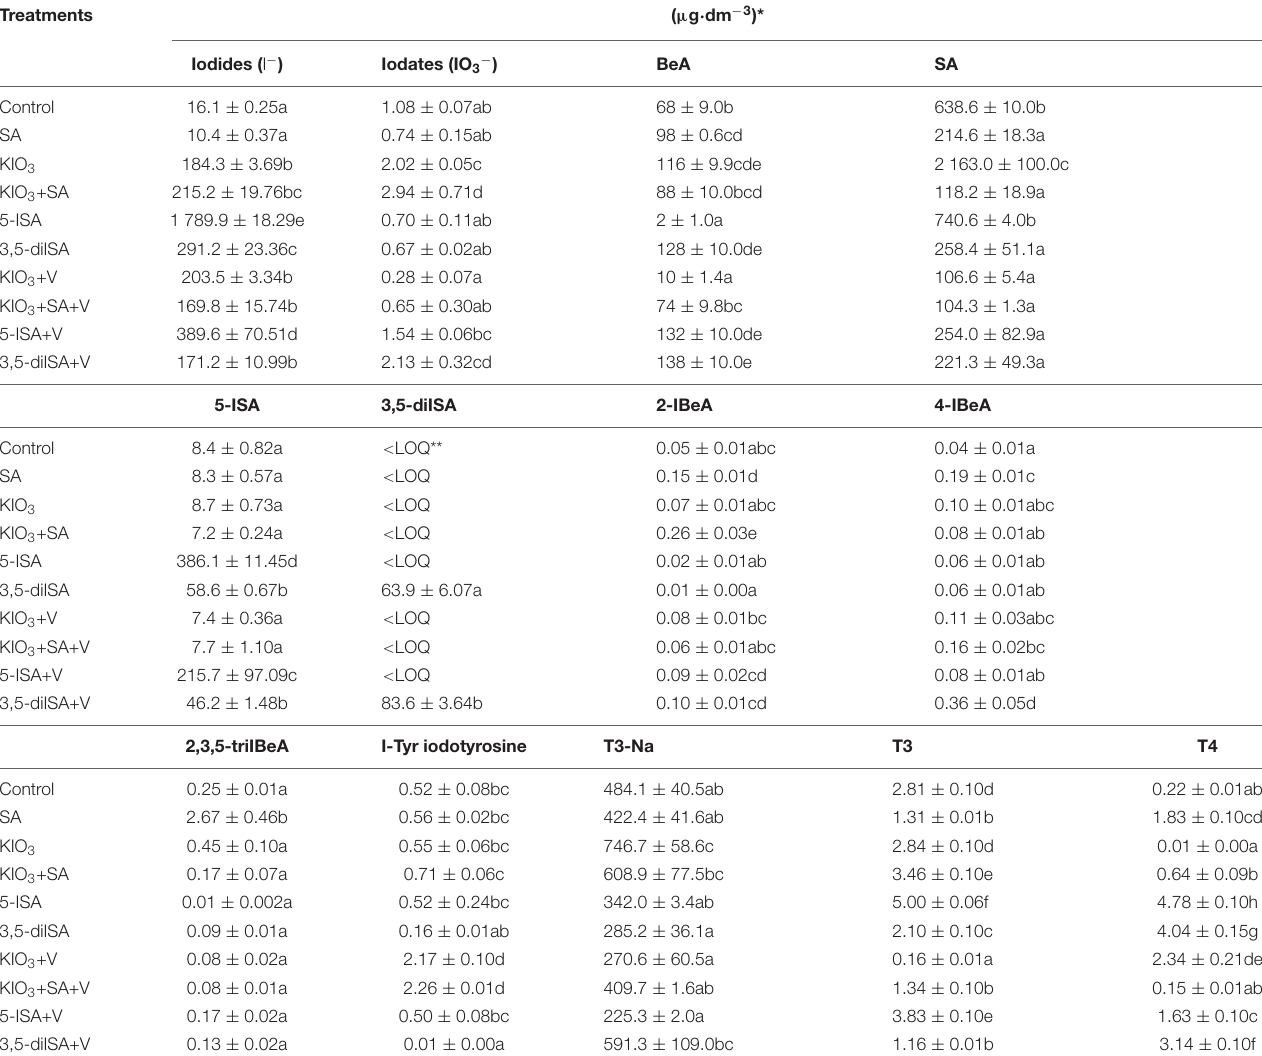
TABLE 4 | Results of the determination of iodides, iodates, organic acids, and iodine metabolites in secretions collected as a result of root pressure (RootSec)—this is in white secretion on the surface of the root neck after cutting the heads (lettuce leaves).